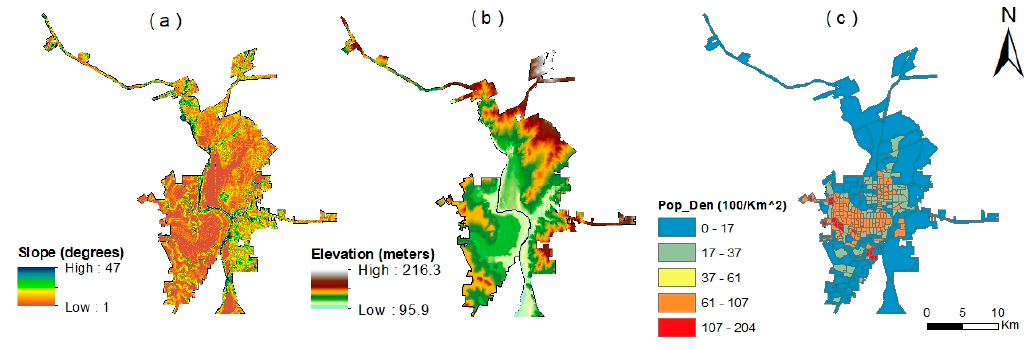
Figure 3. Site specific factors considered for urban growth: ( a ) slope, ( b ) elevation, and ( c ) population density.